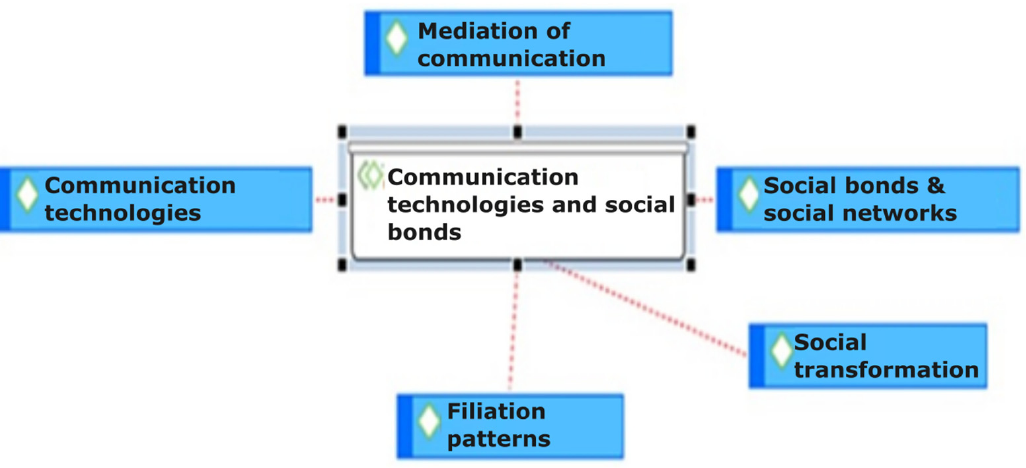
Figure 4. Technologies network of communication and social bond. Source: Self-generated with the use of ATLAS.ti Software.